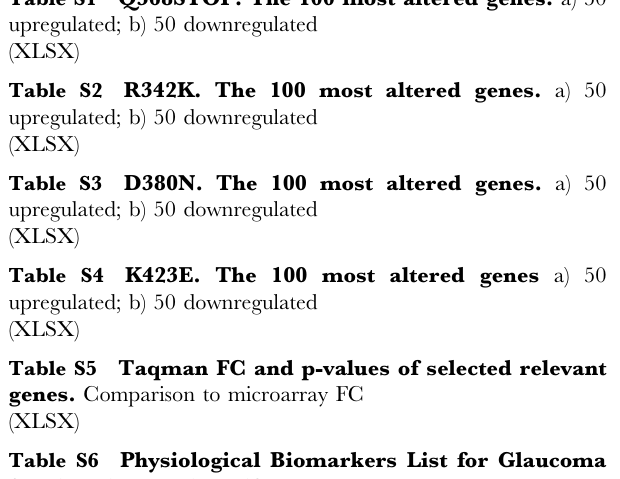
Table S5 Taqman FC and p-values of selected relevant genes. Comparison to microarray FC Table S6 Physiological Biomarkers List for Glaucoma (Trabecular